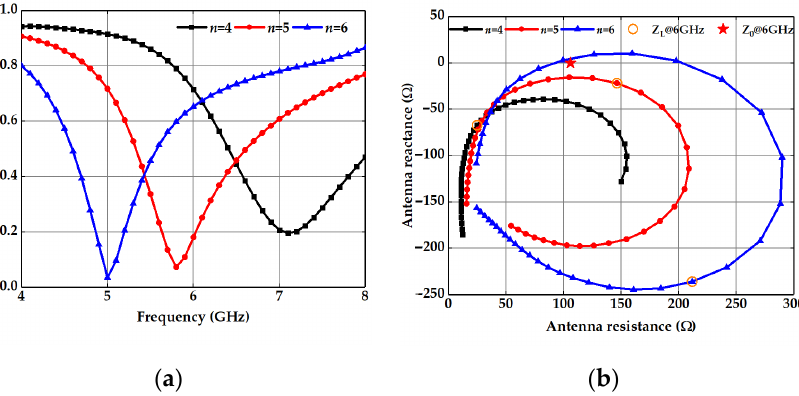
Figure 2. ( a ) | Γ V | of spoof plasmonic dipole antennas ( n = 4, 5 and 6). ( b ) Load impedance of spoof plasmonic dipole antennas ( n = 4, 5 and 6) in the complex plane from 4 GHz to 8 GHz. The star represents the position of Z 0 at 6 GHz, and the circles show Z L of spoof plasmonic dipole antennas ( n = 4, 5 and 6) at 6